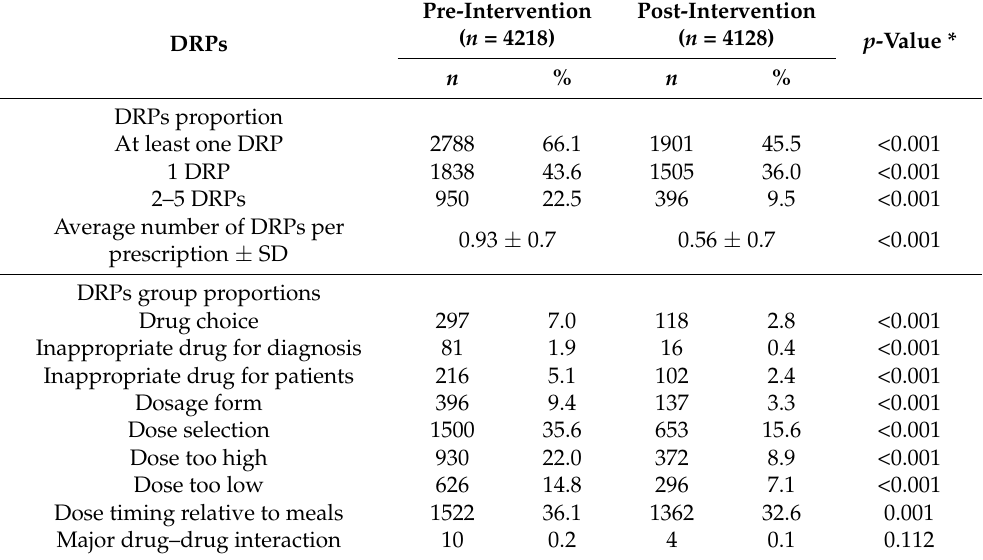
Table 3. Drug-related problems in pre- and post-intervention prescriptions.